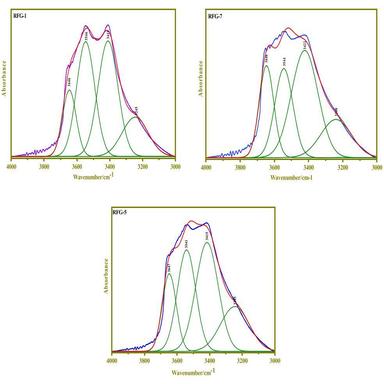
De-convoluted absorption bands of 3000-4000 cm1 .